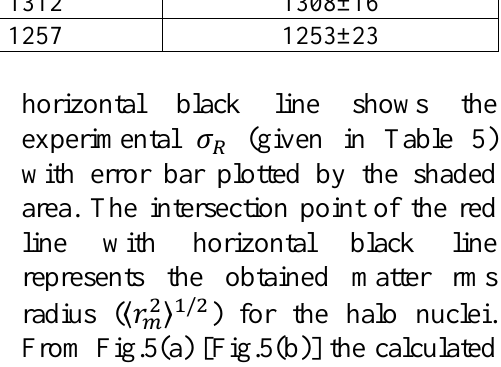
for 23 O + 12 C and 24 F + 12 C 𝝈 𝑹